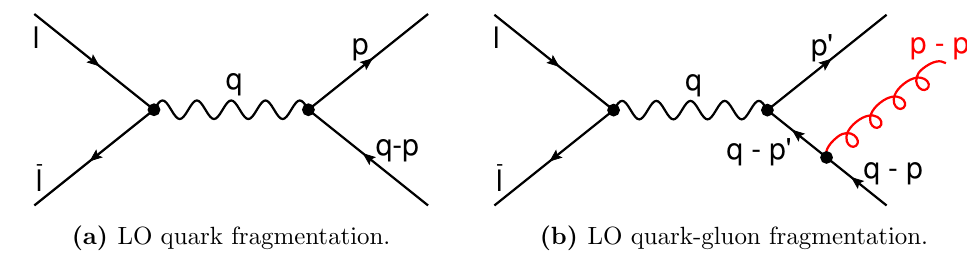
Figure 5. Leading order